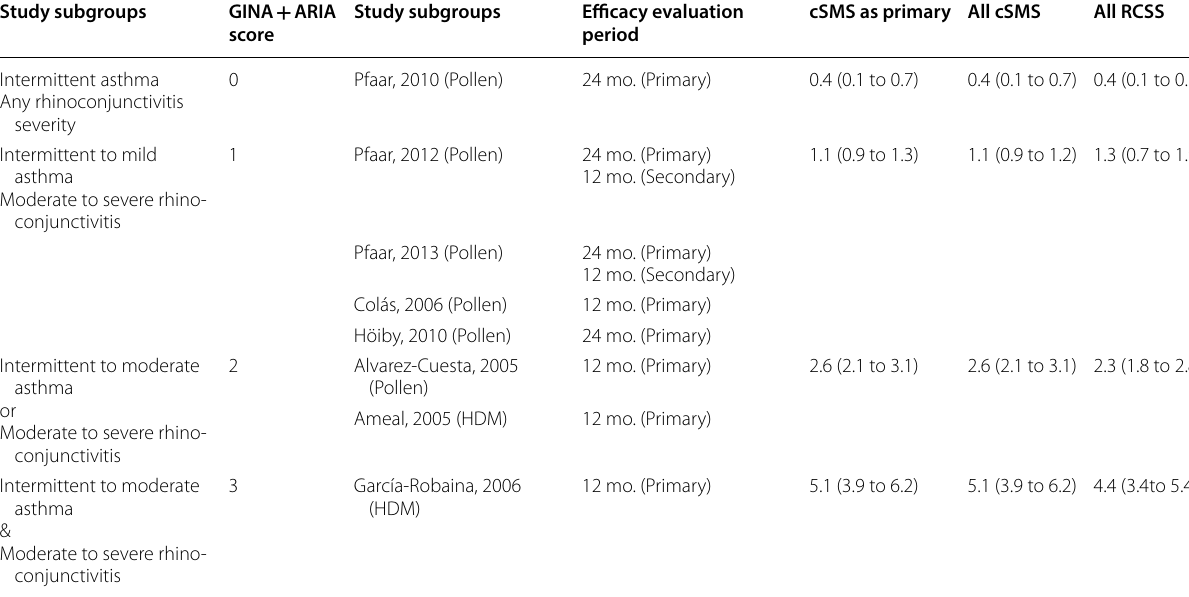
Table 4 Secondary analysis: cSMS and RCSS of AIT with DPAEs compared with placebo (all study